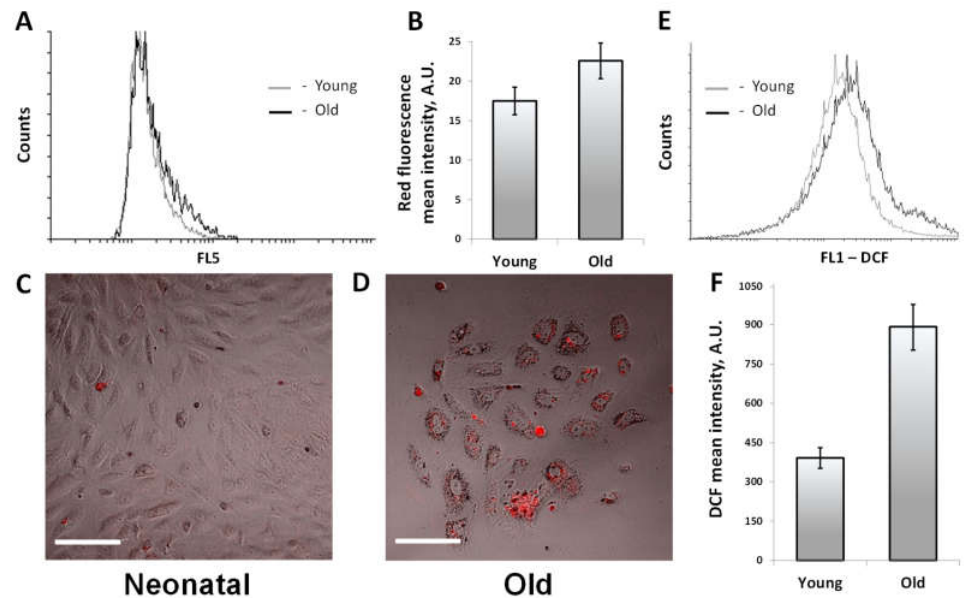
Figure 6. The comparison of lipofuscin content and the level of oxidative stress in cells obtained from the kidneys of young and old rats. ( A , B ) Flow cytometry of primary cultures of RTCs for the assessment of red autofluorescence, and its quantification for young and old rats; ( C , D ) Confocal images of RTCs from neonatal and old rats, and red autofluorescence emission analysis. The scale bar indicates 100 µ m; ( E , F ) Flow cytometry of non-cultured renal tubular cells (NC-RTCs) of young and old rats and stained with DCF-H2.